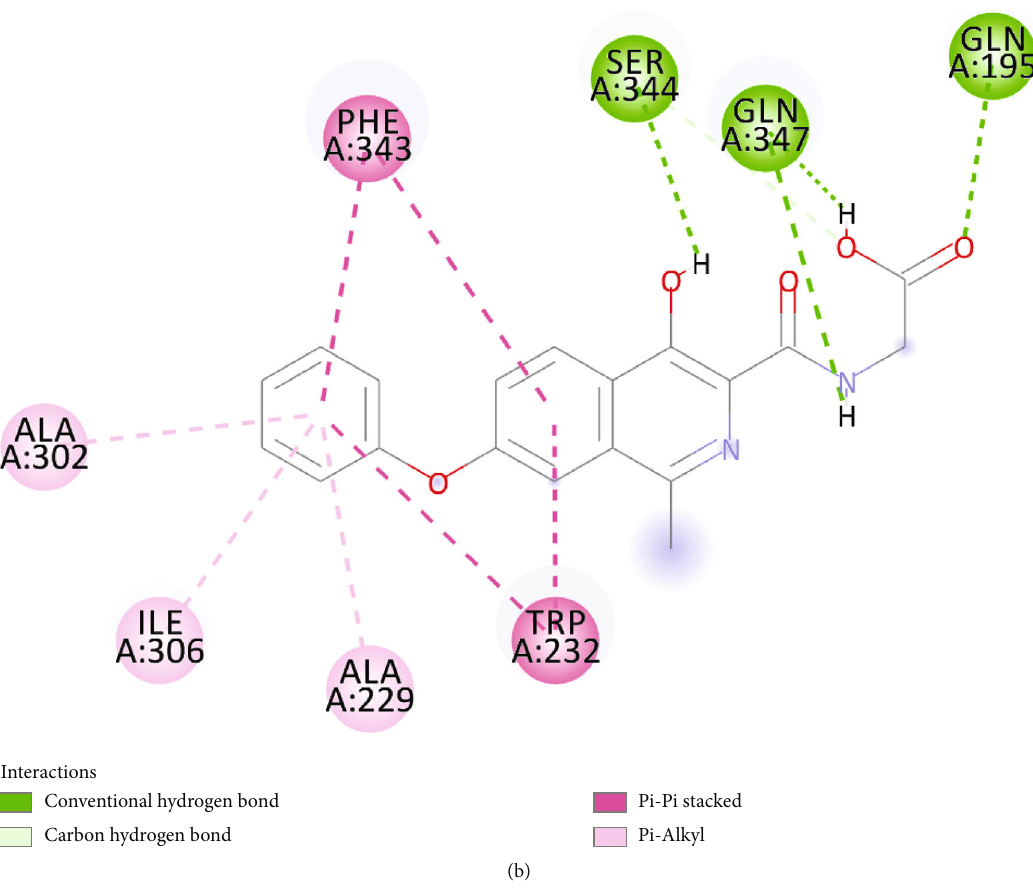
Figure 7: Binding pattern map of TAP1 protein with compound DB04847: (a) 3D binding pattern map of compound DB04847 with TAP1 protein; (b) 2D analysis map of detailed interaction generated by compound DB04847 with TAP1 protein, in which the α -helix of the protein backbone is shown as a cyan band and the β -fold is shown as a magenta band. Compound DB04847 is shown as a plum-red stick, the amino acid residues that produce the interaction are shown as cyan sticks, and the colors of the heteroatoms in the compound and amino acid residues are shown by element type. Hydrogen bonds are shown as green dashed lines, π - π stacked interactions are shown as magenta dashed lines, and π -Alkyl interactions are shown as pink dashed